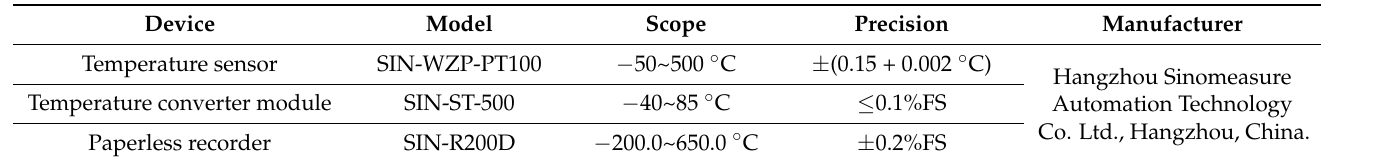
Table 3. Parameters of the temperature measurement system.